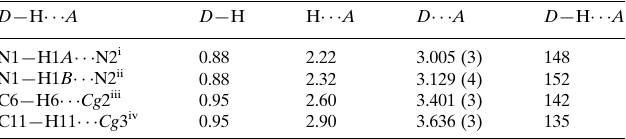
ment: CrystalClearSM Expert ; data reduction: CrystalClearSM Expert ; program(s) used to solve structure: SUPERFLIP